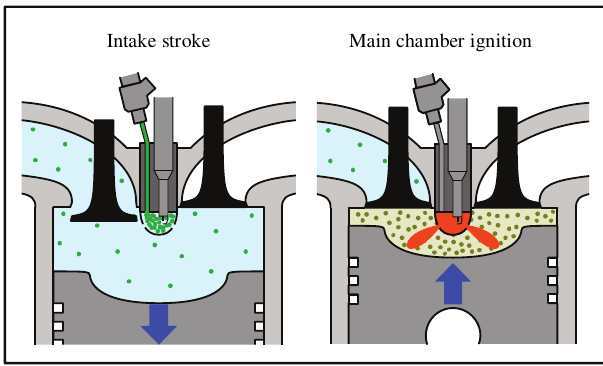
Fig. 6. Schematic of engine 2 operated with scavenged pre-chambers (graphics are taken from [13] and adapted)